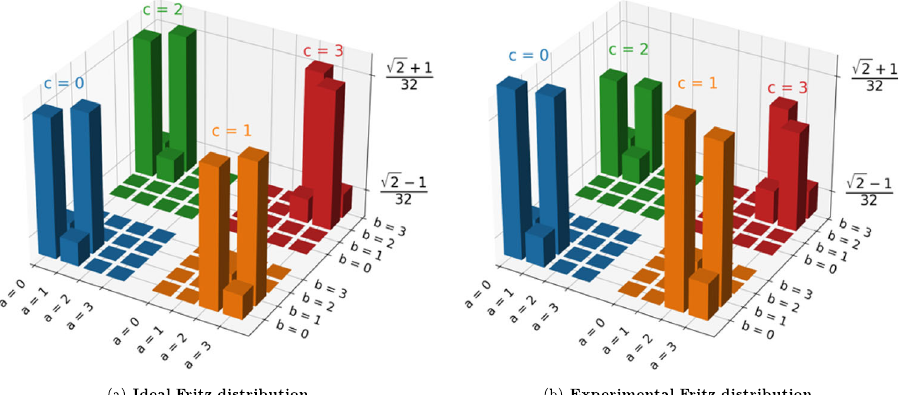
Fig. 3 | The Fritz distribution, theoretical versus experimental. a Ideal Fritz distribution computed by choosing ρ AB = ð ∣ HV i (cid:4) ∣ VH iÞ = state); Λ AC = Λ BC as classically, perfectly correlated mixed states; and the ideal measurementoperatorsdescribedinEq.(5). b Experimentaldistributionmeasured inanexperimentalrun.TheerrorbarsarecalculatedusingPoissonianstatisticsand